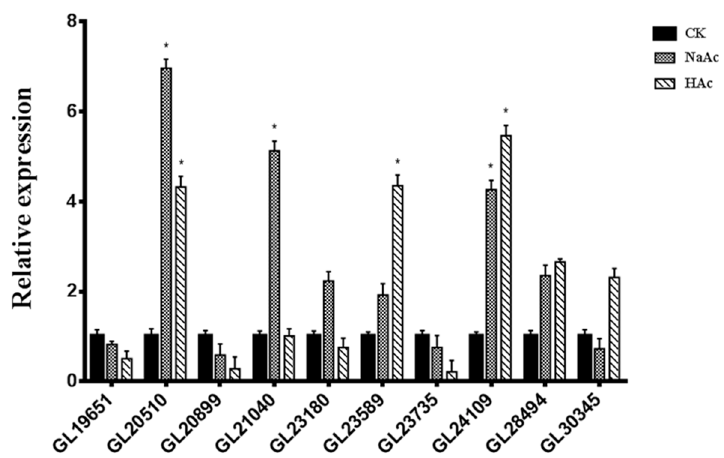
Figure 5. Transcriptional levels of the homologous acs genes in the CK strain and the treatment group. The expression level of the samples from the CK strain is defined as 1.0, and the expression levels in the treatment strain are displayed in relation to the reference sample. The error bars indicate the standard deviations from three independent samples. * indicates statistical significance ( p < 0.05) compared to the CK strain.